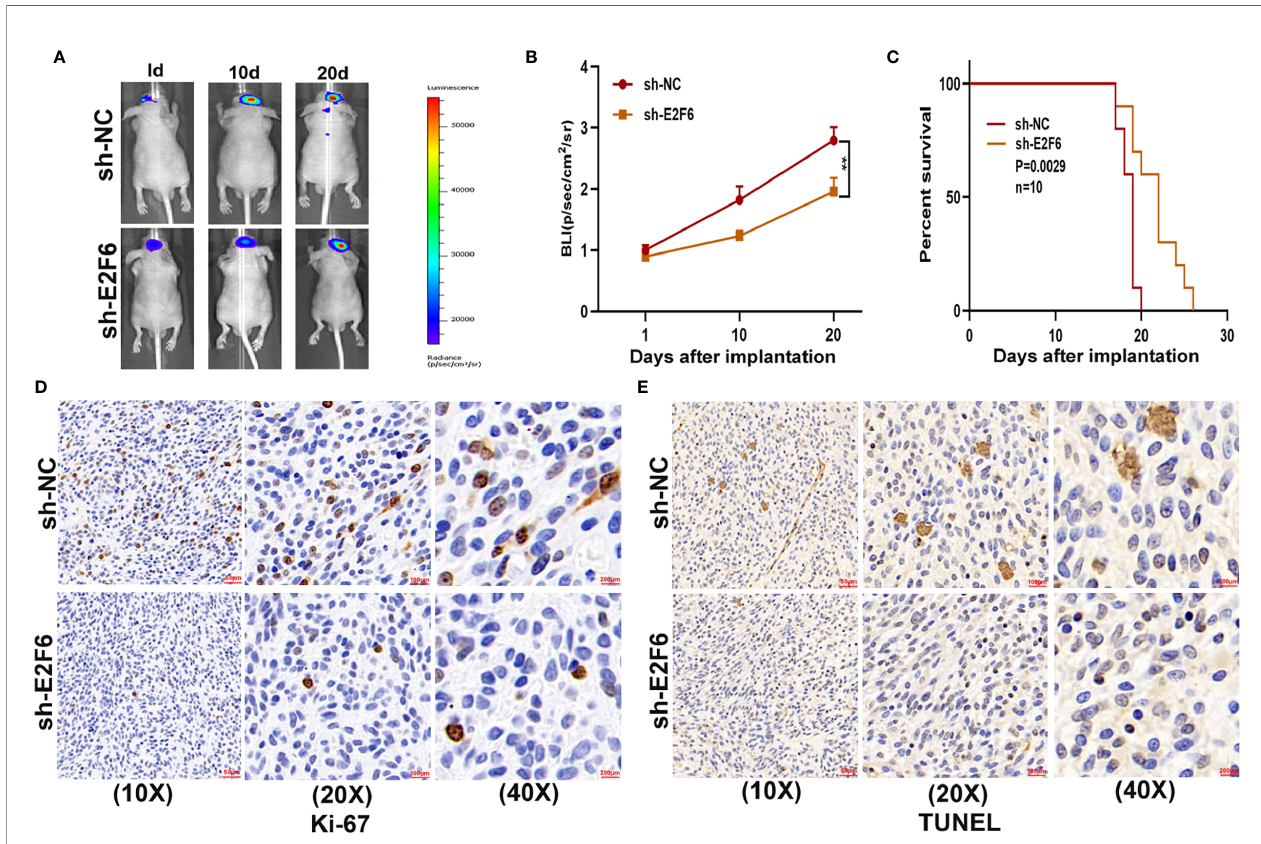
FIGURE 8 | E2F6 promotes glioma growth in vivo . (A, B) The bioluminescent images of the tumours formed in the brains of nude mice were acquired at days 1, 10 and 20 after implantation. (C) Overall survival was compared between the sh-E2F6 and sh-NC groups by Kaplan-Meier survival curves. (D) Immunohistochemistry for Ki-67 in the sh-E2F6 and sh-NC groups. (E) Immunohistochemistry for TUNEL staining in the sh-E2F6 and sh-NC